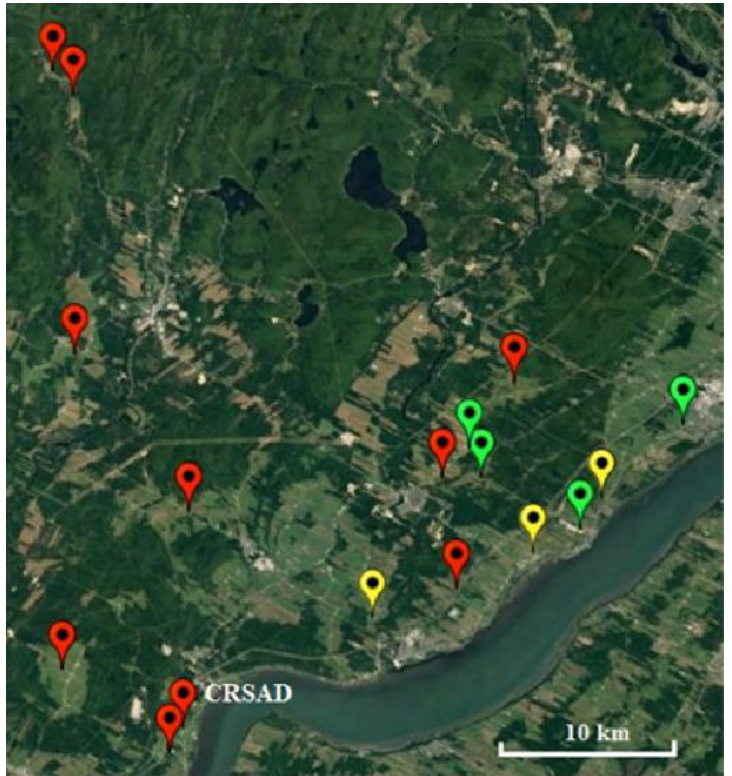
Figure 2. Map of the location of the different apiaries used for the colonies of the CRSAD selection pro-gram. From 2010 to 2016, these colonies were randomly distributed on four of these apiaries, and, since 2016, on five. Each year, the location of some of the apiaries used for the selection program changed. The tags in red correspond to the location of apiaries used between 2010 and 2016, in yellow to the location of apiaries used between 2010 and 2019 and in green to the location of apiaries used between 2016 and 2019 (Source: screenshot of Google TM